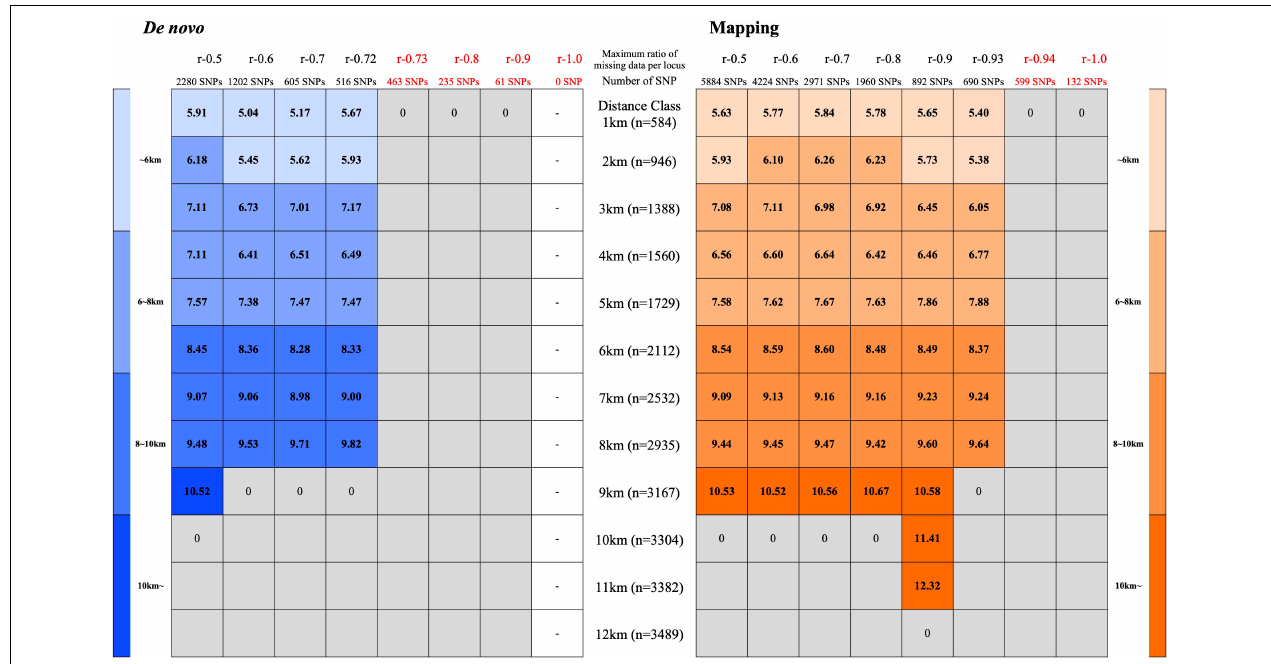
FIGURE 2 | Outcomes of spatial genetic autocorrelation analysis with the different distance classes (1–15 km) using different ratios of missing data per locus ( r = 0.5–1.0; r–1.0 for de novo was failed). Note that the x-intercepts were converted to zero when the correlation was not significantly different from zero and shown in gray. The color counter reflects the size of the x-intercept (lighter colors indicate smaller x-intercept values).